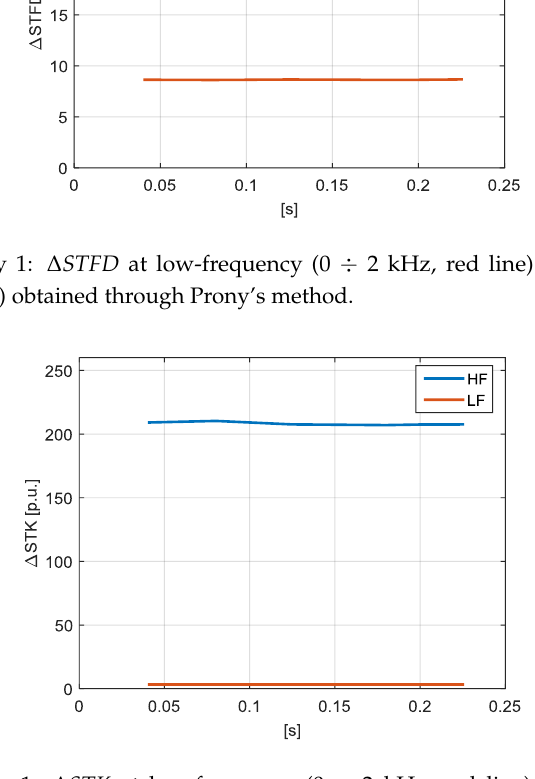
Figure 31. Case study 2: STDE at low-frequency (0 ÷ 2 kHz, red line) and at high-frequency (2 ÷ 150 kHz, blue line) obtained through STFT. Figure 32. Case study 2: Δ STFD at low-frequency (0 ÷ 2 kHz, red line) and at high-frequency (2 ÷ 150 kHz, blue line) obtained through STFT.